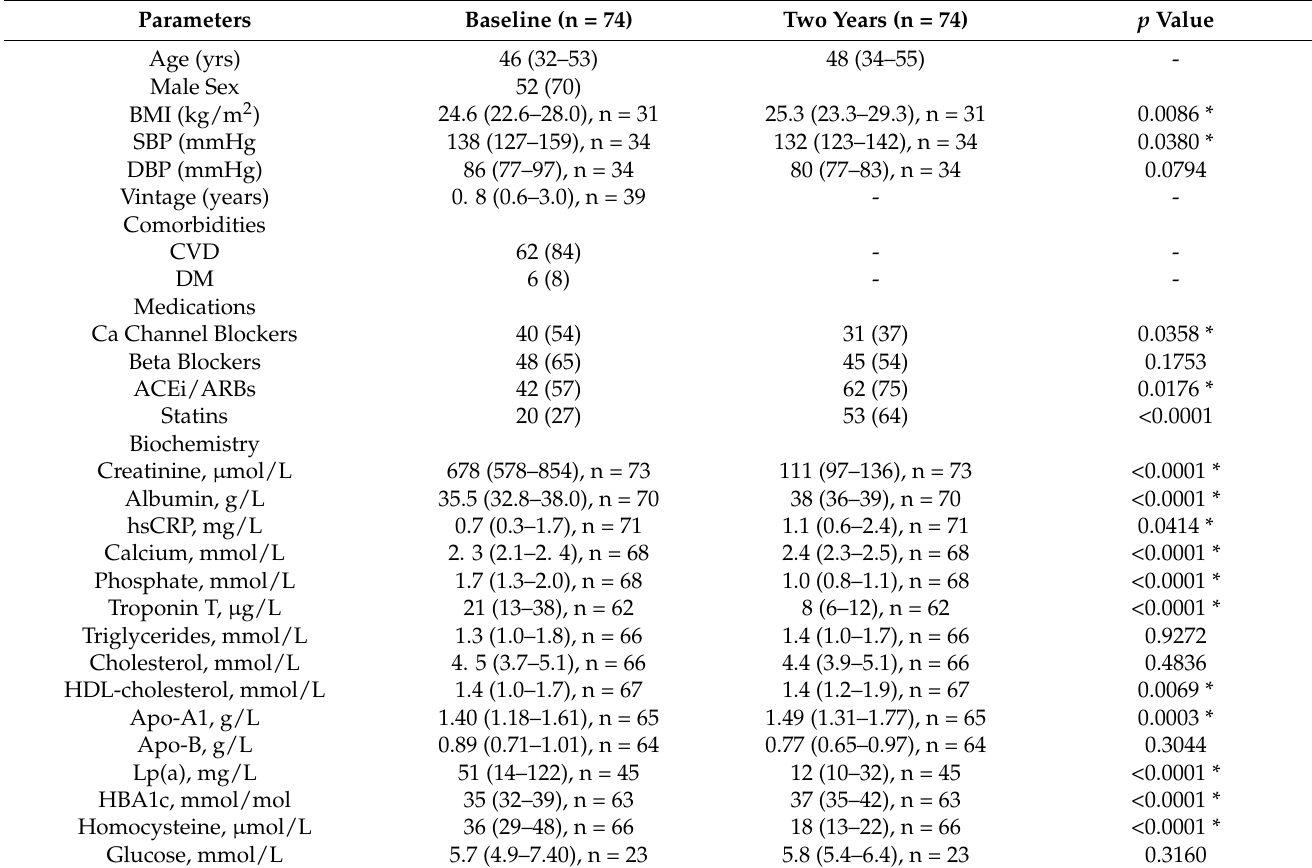
Table 1. Clinical profile of KT patients at baseline and two years